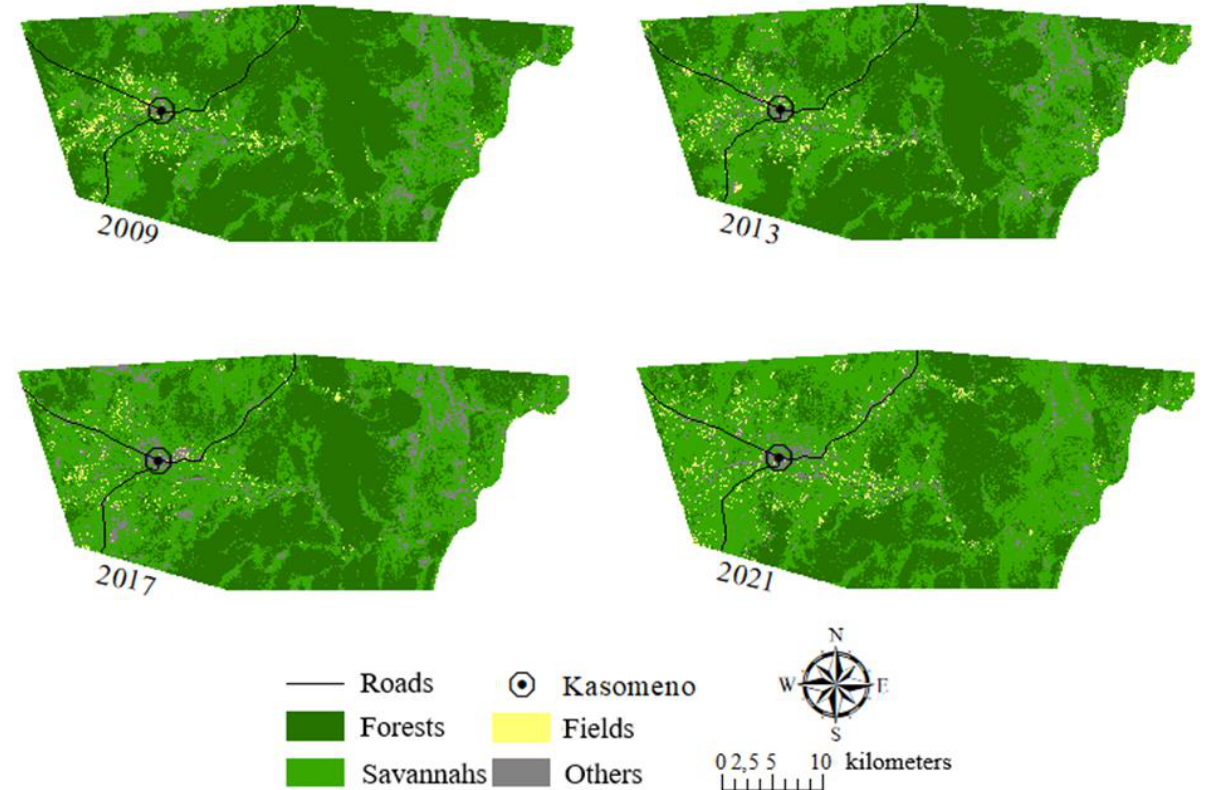
Figure 2. Land cover maps of the Kasomeno region in 2009, 2013, 2017 and 2021, obtained from supervised classifications of Landsat images. The ‘Other’ class refers to other land uses.